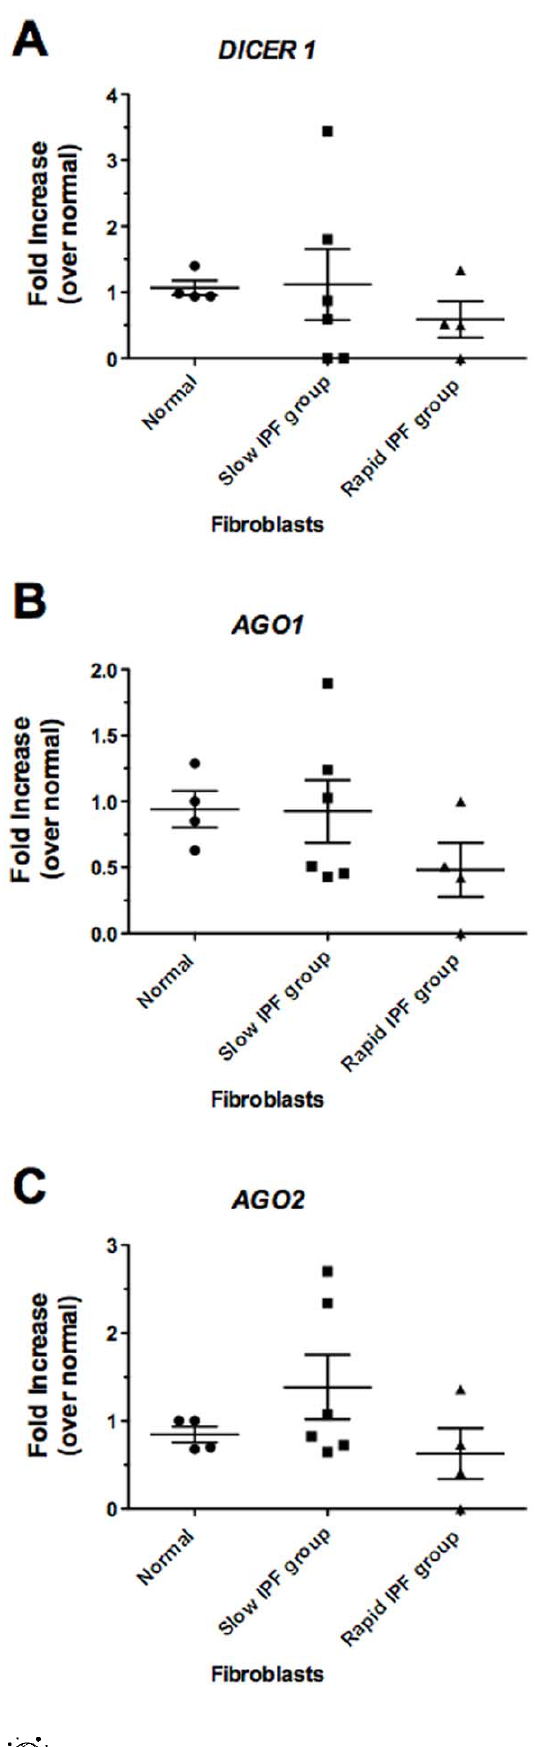
Figure 6. Transcript expression of A) DICER1 , B) AGO1 , & C) AGO2 in normal, slow IPF, and rapid IPF patient fibroblasts. Fibroblasts cultured from normal, slow IPF, and rapid IPF lung biopsies were exposed to media alone. Total RNA from cells was analyzed by qRT-PCR for transcript expression 4 hours after treatment. Relative expression values were normalized to the normal group (n=4) and compared to the slowly progressive (n=6) or rapidly progressive group (n=3). Expression values were also normalized to GAPDH. Data are presented as mean 6 SE.